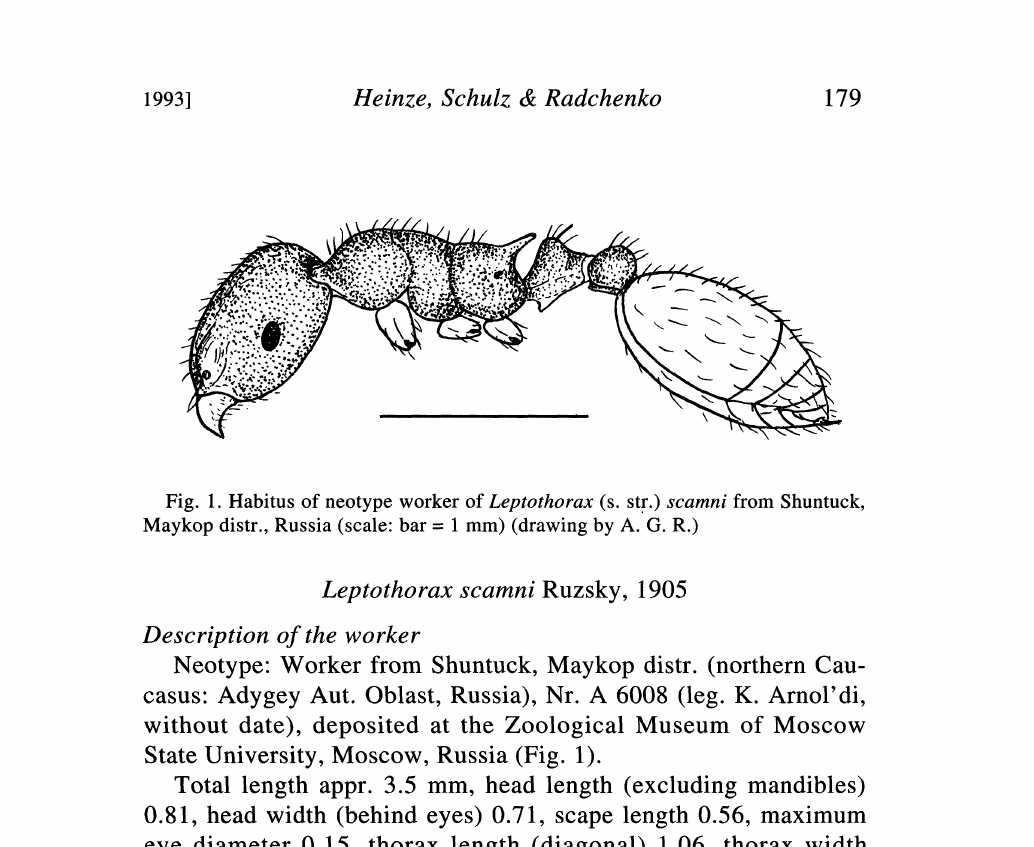
Fig. 1. Habitus of neotype worker of Leptothorax (s. sty.) scamni from Shuntuck, Maykop distr., Russia (scale: bar mm) (drawing by A. G.